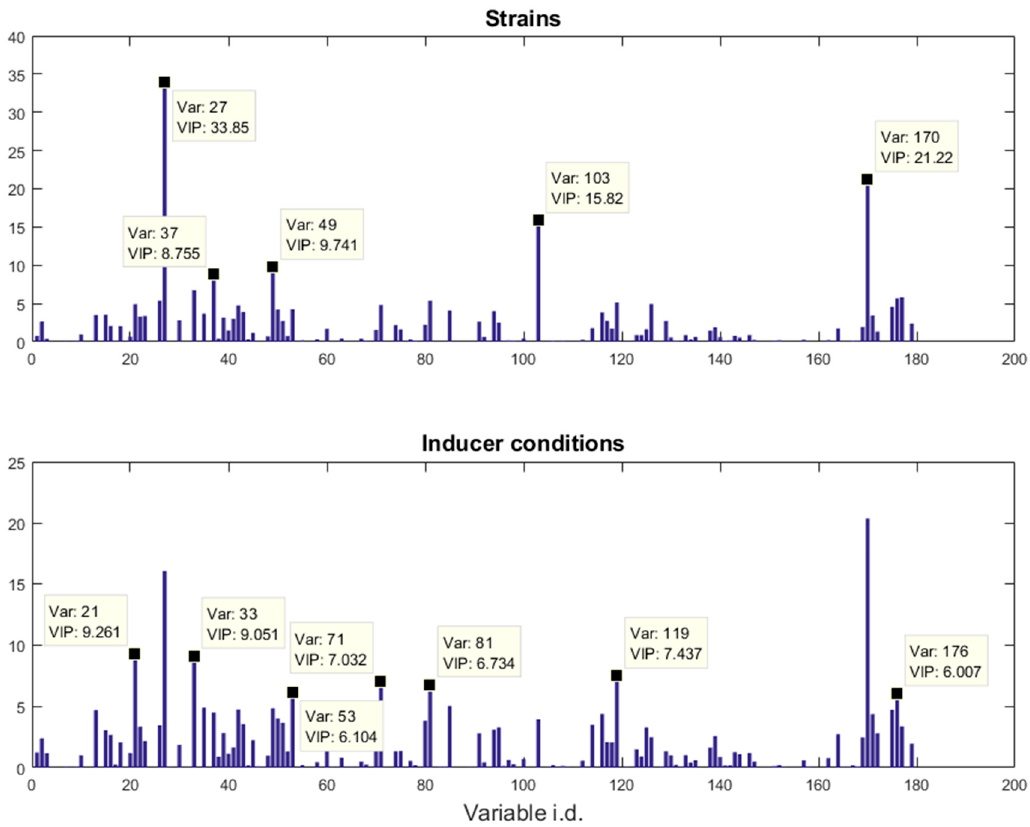
Figure 3. VIP score plots for the riboswitch data. The variable identifications and their corresponding VIP scores values were annotated in the data tips. Note that each metabolite is only annotated once, if a metabolite is significant in both VIP score plots (e.g., variable 27), only the higher one is annotated.